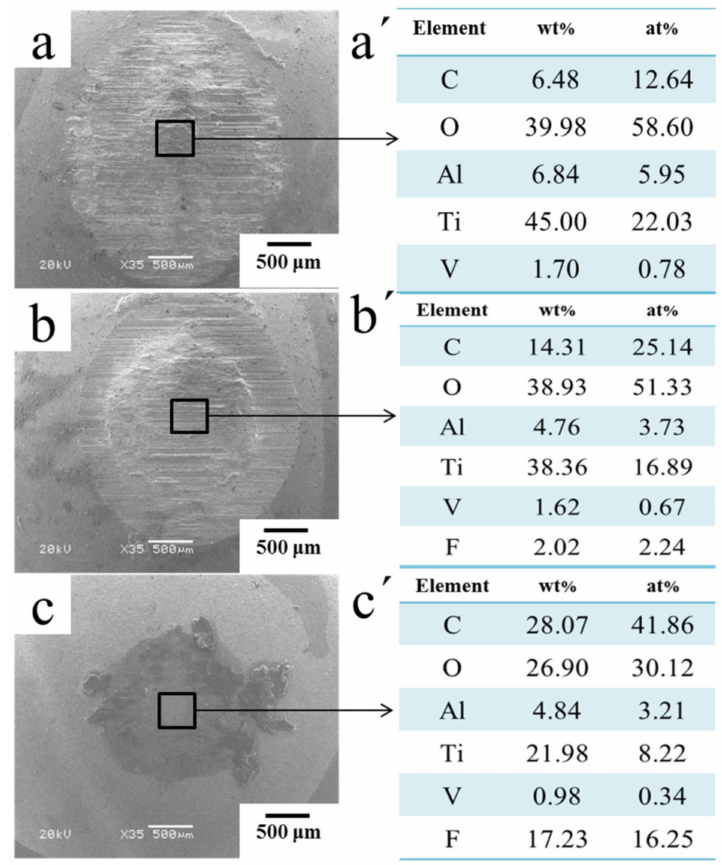
Figure 11. SEM images and EDS contents of worn surfaces of TC4 balls corresponding to untextured surface ( a , a’ ), TO surface ( b , b’ ), TO+ textured surface ( c , c’